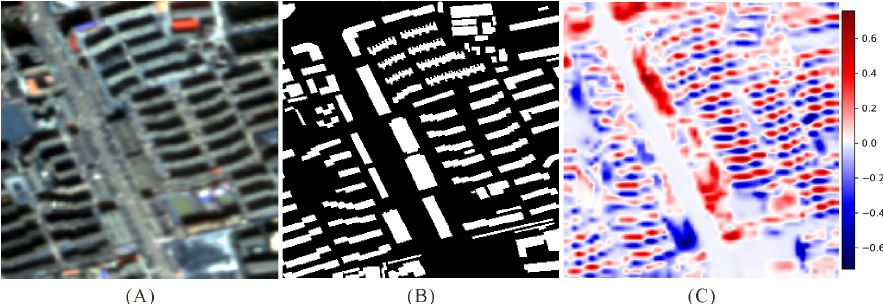
Figure 6. The impact of the GT can be better recognized by a heat map of the predicted score. The building predicted scores are the output of the sigmoid layer with the range [0, 1]. ( A , B ) The image and the corresponding label, respectively. ( C ) Heatmap obtained by visualizing the values of the difference between the prediction score of SGFANet and that of SGFANet without